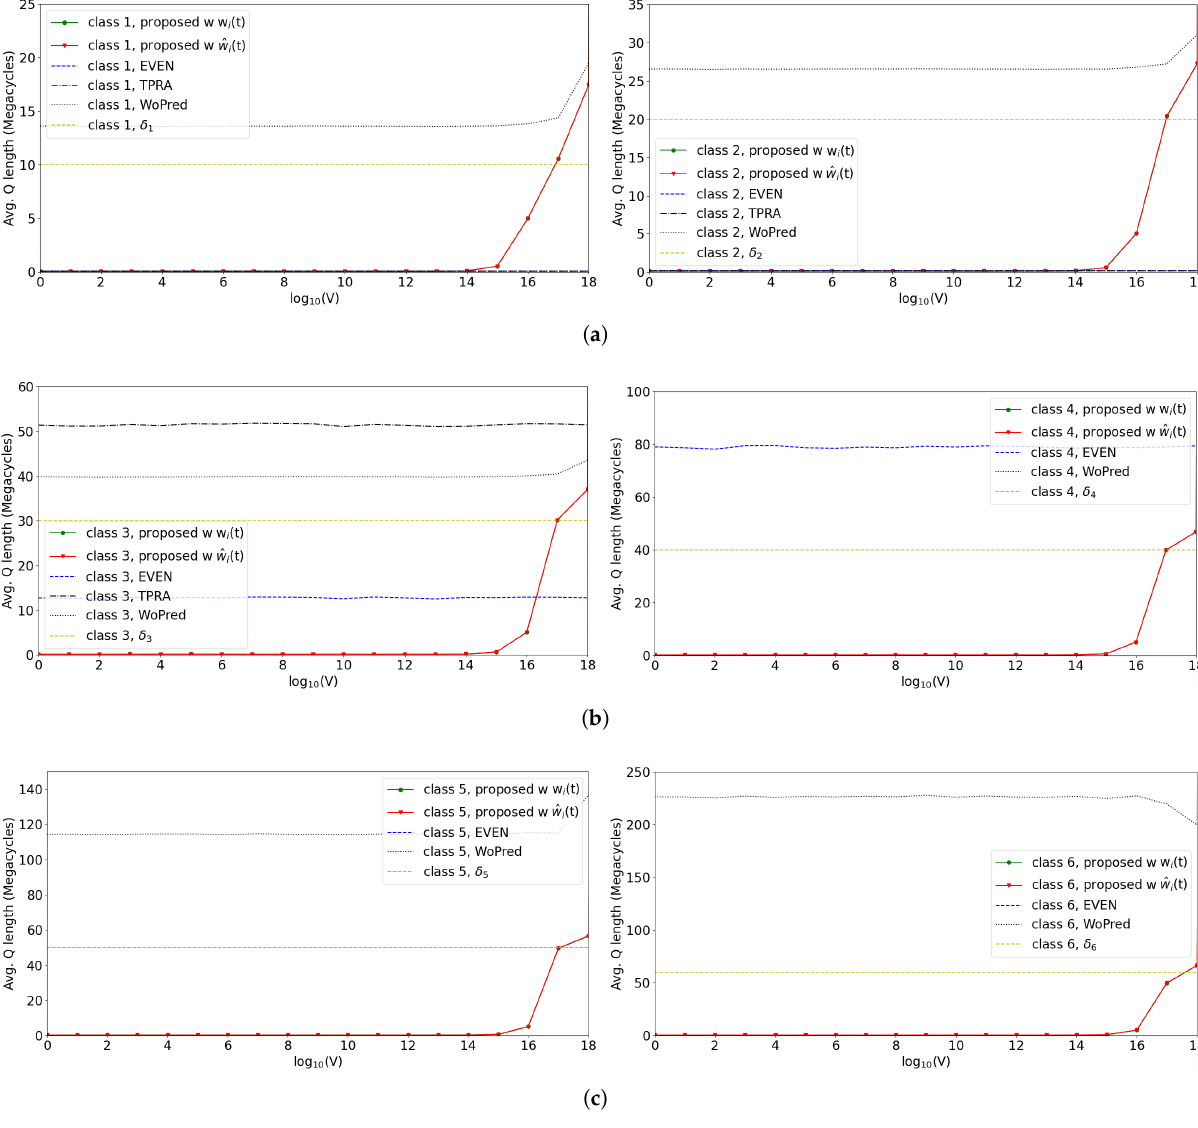
Figure 8. Average queue length with different Vs when the number of classes is 6. In Classes 4–6, the average queue lengths obtained by TPRA are much larger than those achieved by other methods. Therefore, in Classes 4–6, we omit the case when TPRA is applied and adjust the range of the x-axis